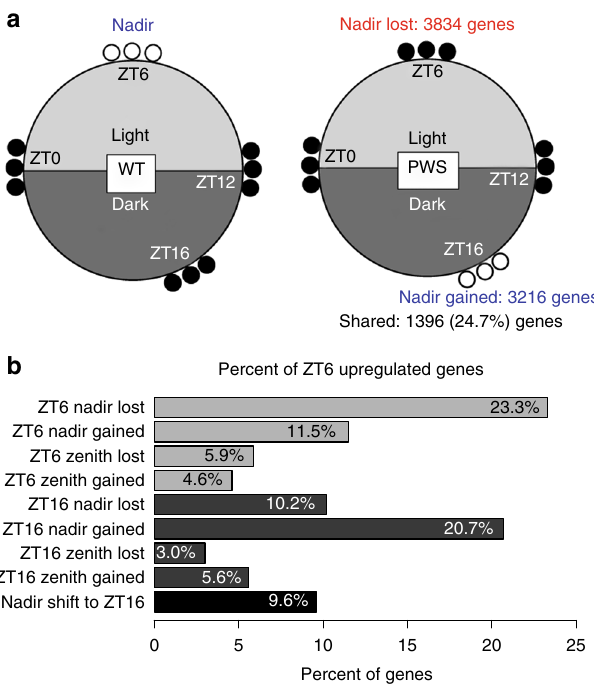
Fig. 4 Genes which lose a ZT6 methylation nadir or gain a ZT16 nadir in PWS overlap signi fi cantly with genes upregulated at ZT6 and enhancers. a Graphical representation of the rhythmic DNA methylation pattern changes in PWS for the two largest groups of genes (ZT6 nadir lost and ZT16 nadir gained). Filled circles represent methylated and empty circles represent unmethylated CpGs. b Percent overlap of genes upregulated at ZT6 in PWS mouse cortex by RNA-seq analysis with each PWS-speci fi c diurnal methylation category